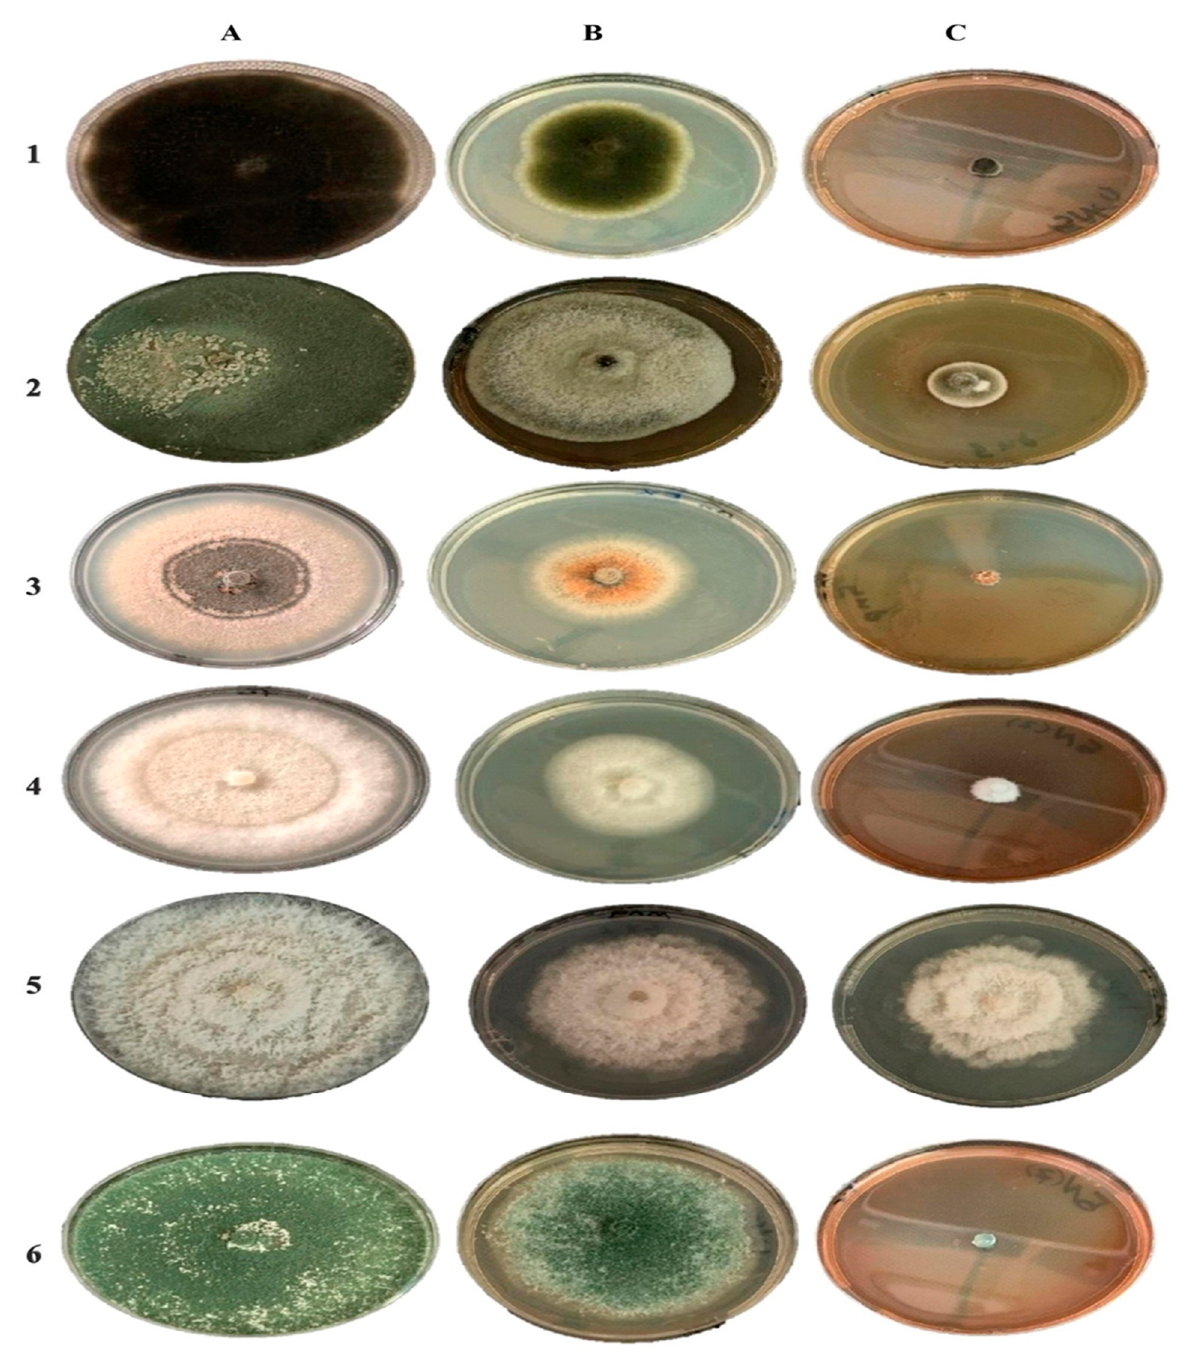
Figure 7. Antifungal activity of the red currant aqueous extracts and red currant-AgNPs against a panel of plant pathogenic fungi: ( A ) control, not treated; ( B ) treated with aqueous extracts of red currants; ( C ) treated with red currant-AgNPs. 1 — Alternaria alternata ; 2 — Botrytis cinerea ; 3 — Colletotrichum musae ; 4 — Fusarium oxysporum ; 5 — Pestalotiopsis mangiferae ; 6 — Trichoderma harzianum